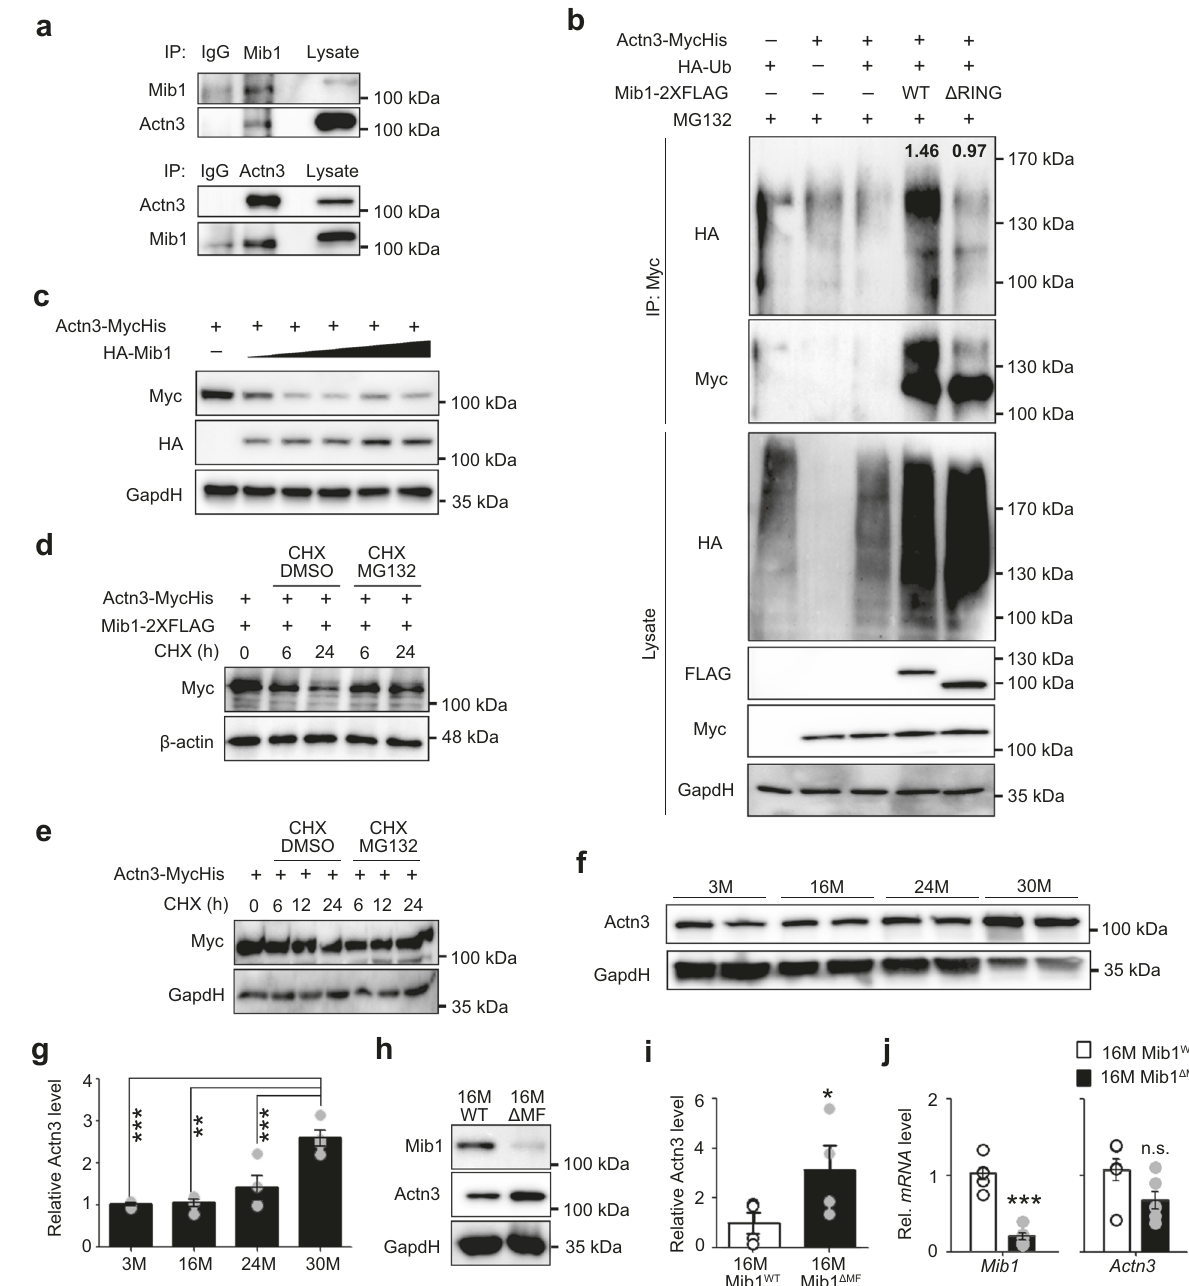
Fig. 4 Regulation of Actn3 via Mib1-mediated proteasomal degradation pathway in skeletal muscles. a Endogenous interaction of Mib1 and α -Actn3 (Actn3) in GA muscle lysates. GA muscle lysates from 3-month-old WT mice were subjected to endogenous IP using anti-Mib1 and Actn3 antibody. Mouse and rabbit IgG were used as a nonspeci fi c control. b IB analysis of ubiquitination and proteasomal degradation of Actn3 in 293T cells. The 293T cells were transfected with indicated plasmids and treated with 10 μ M MG-132 for 6 h. Whole lysates were subjected to IP using anti-Myc, followed by IB analysis. The intensities of HA (Ub) protein of lanes 4 and 5 were 1.46 ± 0.12 and 0.97 ± 0.07, respectively ( p = 0.03). c IB analysis of Mib1- dependent Actn3 protein levels. The 293T cells were transfected with 4 μ g of MycHis-tagged Actn3 and 0.5, 2, 4, 8, and 16 μ g of HA-tagged Mib1. d , e IB analysis of Actn3 protein degradation in 293T cells with ( d ) or without ( e ) Mib1-2× FLAG. 293T cells were transfected with MycHis-tagged Actn3 and/or HA-tagged Mib1 followed by treatment with cycloheximide (CHX) and MG-132 or 0.1% DMSO for the indicated times. f , g IB analysis ( f ) and the intensity ( g ) of Actn3 expression in GA muscles of WT mice with indicated ages. h , i IB analysis ( h ) and the intensity ( i ) of Mib1 and Actn3 expression in GA muscles of 16-month-old Mib1 WT and Mib1 Δ MF mice ( p = 0.019 for i ). j Mib1 and Actn3 mRNA levels in GA muscles ( p = 2.06E − 05 for Mib1 and 0.0519 for Actn3 ). The intensity of protein expression of IB was quanti fi ed by densitometry. Data are shown as representatives of at least three independent experiments. Data are presented as means± s.e.m. n = 4 ( f , g ), n = 6 ( h – j ) mice per genotypes. One-way ANOVA for ( g ). Two-tailed Student ’ s t test for ( i , j ). * P < 0.05; ** p < 0.01; *** p < 0.001; n.s. not signi fi